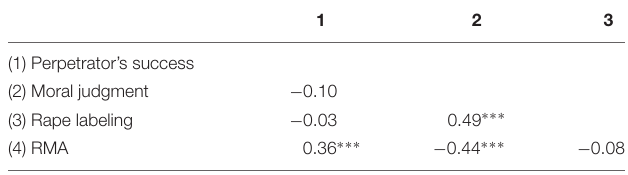
TABLE 5 | Correlations between the variables in Study